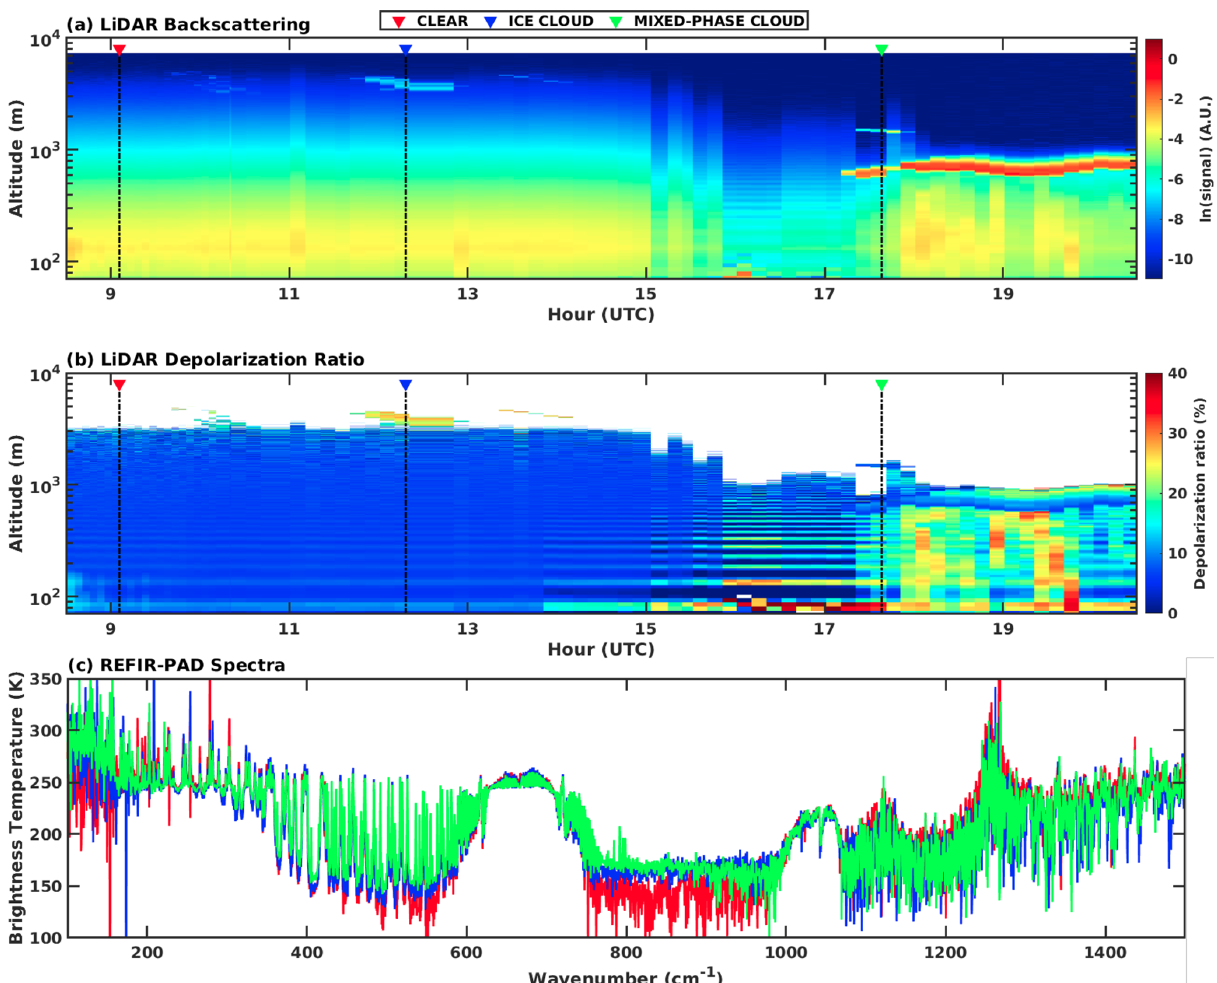
Figure 2. (a) Lidar backscattering and (b) depolarization ratio for 2 January 2013. (a, b) Different sky conditions are highlighted by a vertical dashed line. A red triangle indicates clear sky, a blue triangle is used for ice clouds, and a green triangle is used for mixed-phase clouds. (c) REFIR-PAD spectra corresponding to the three sky conditions highlighted in the upper and middle panels. The same color code is used.